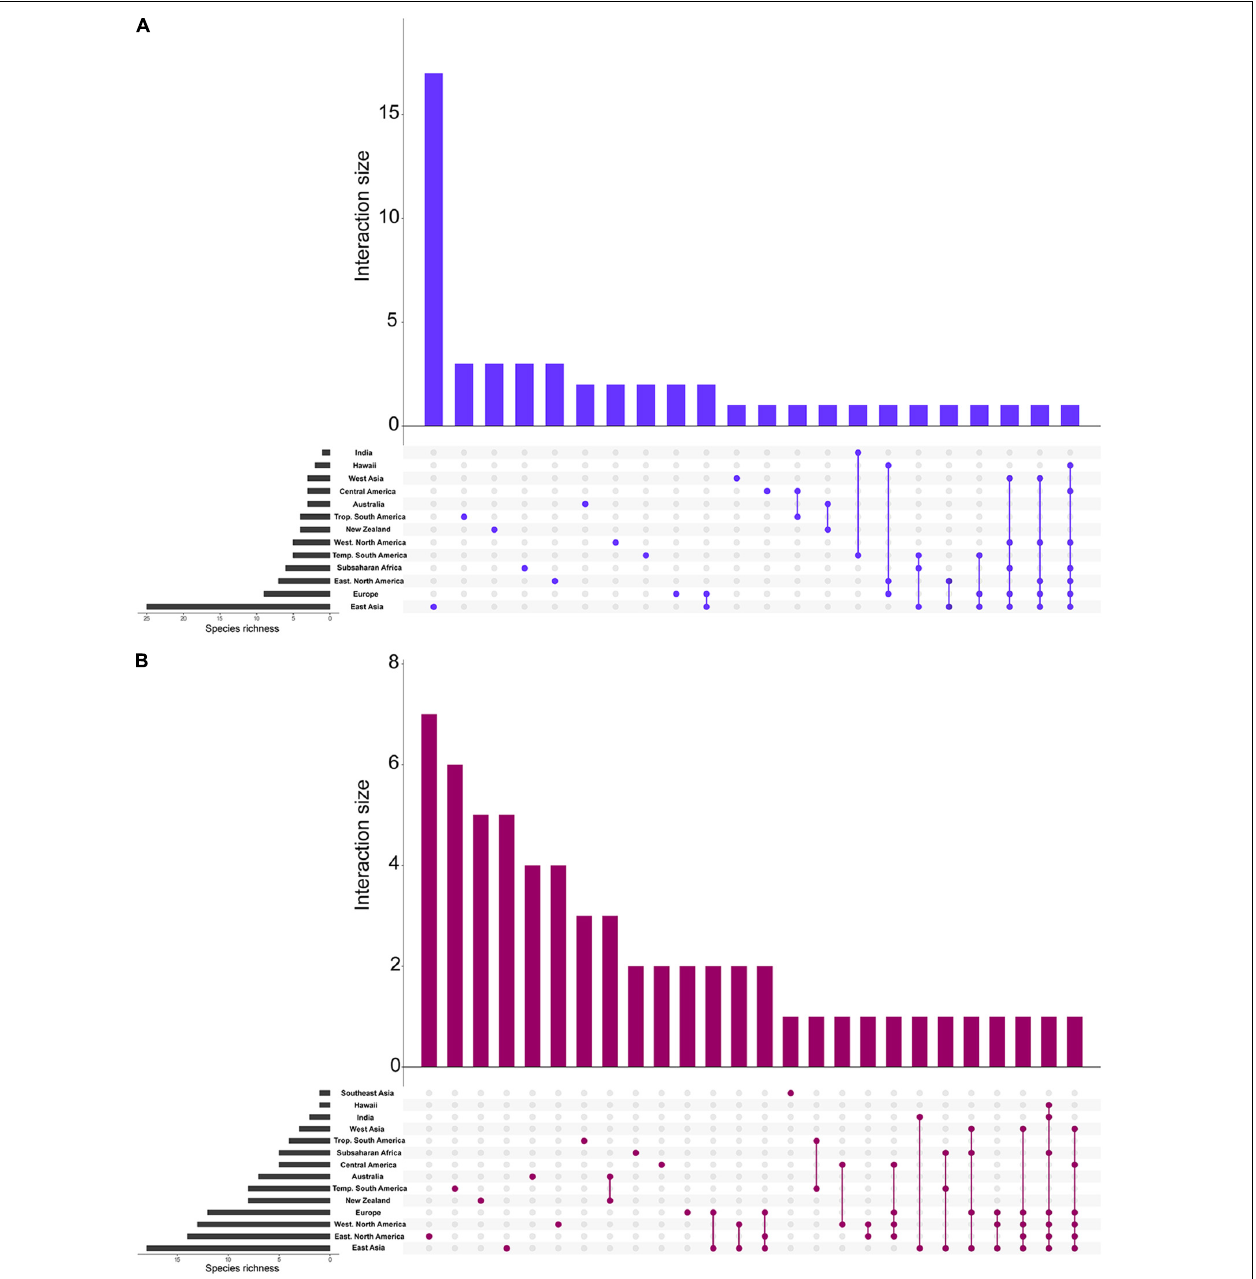
FIGURE 2 | Species richness in each of the biogeographic regions. Bar graphs showing the total richness of our species clusters in each biogeographic region and the combination of biogeographic regions. (A) ITS1 and (B) ITS2. The species richness for each vertical bar corresponds to the number of species that are solely found in the biogeographic regions corresponding to the colored circle(s) below. The species richness for the horizontal insets correspond to the total species richness within each biogeographic region.